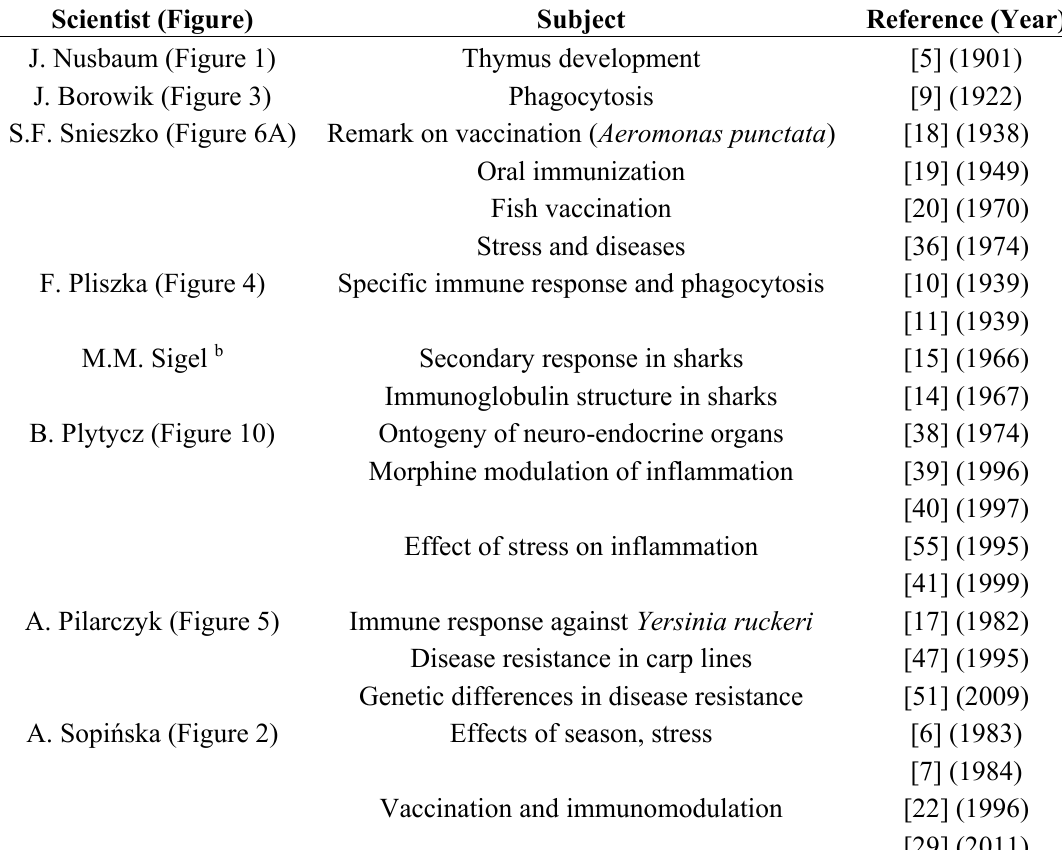
Table 1. Polish scientists in the field of fish immunology starting their career between 1900 and 1985 a .